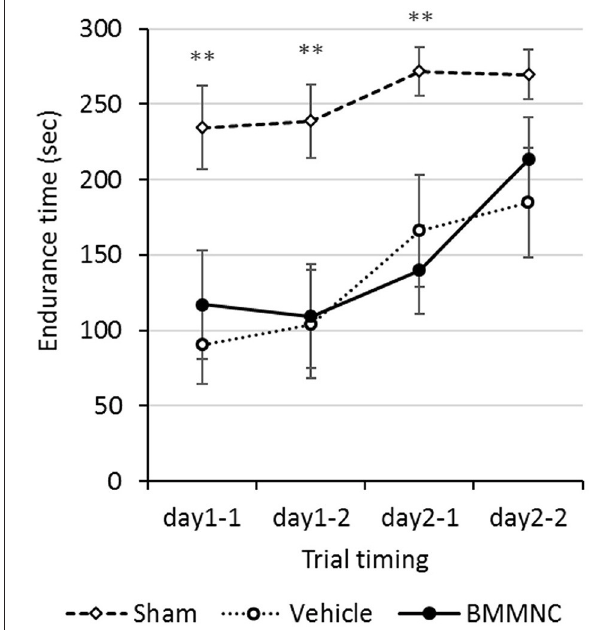
FIGURE 6 | Rotarod treadmill. Rotarod treadmill test was performed on P24–25. The endurance time was compared among all three groups. Rats in the BMMNC group and vehicle group fell down significantly earlier than in those in the sham group from the first to the third trial (** p < 0.01, Dunnett’s test). The endurance time was not significantly different between the BMMNC and vehicle groups in any trials. Open squares and dashed line: sham, n = 9;